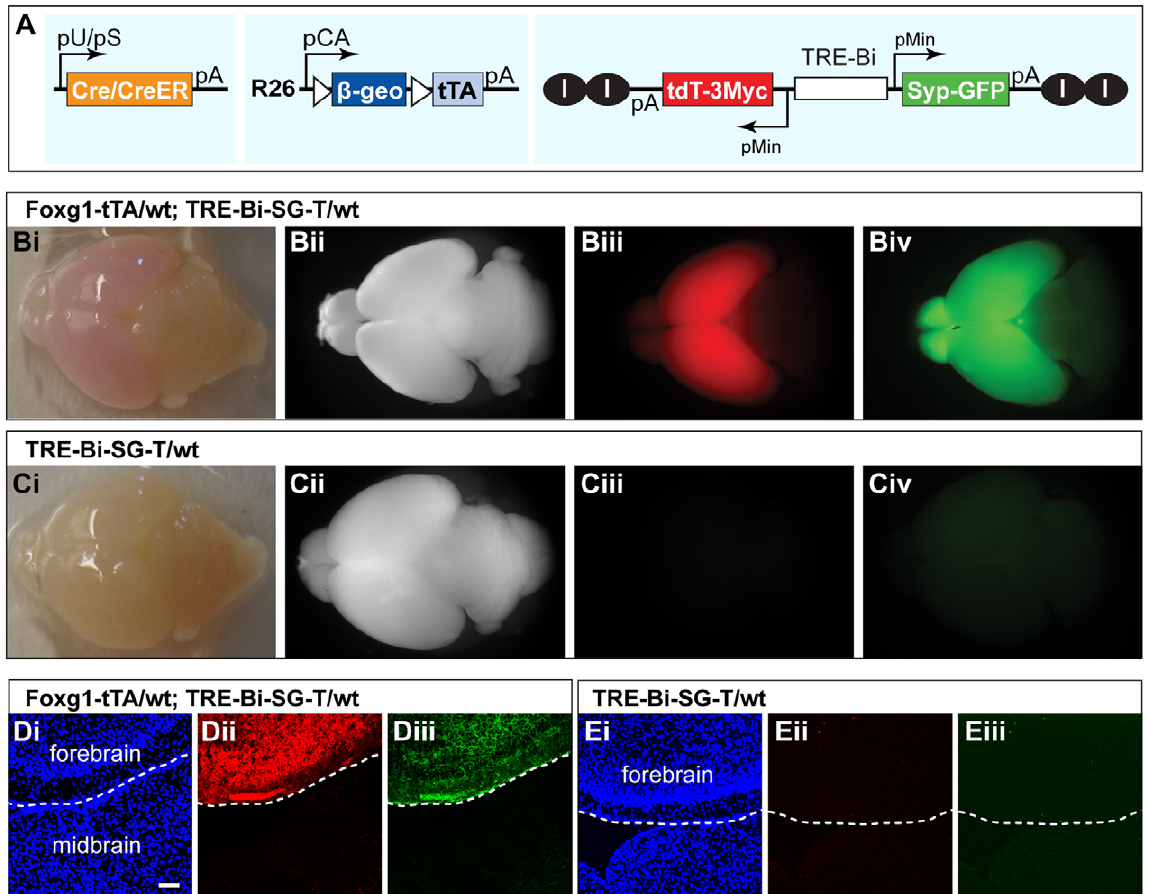
Figure 1. Strategy for creating a transgenic tripartite system for presynaptic labeling invivo . (A) Schematic representation of the three transgenes used for in vivo synaptic labeling: A ubiquitous (pU) or tissue-specific (pS) promoter driven Cre/CreER transgene (left); A Cre/CreER- dependent tTA knock-in (ZtTA) targeted to the ROSA26 locus (middle); A bidirectional TRE (TRE-Bi) transgene driving Synaptophysin-GFP (Syp-GFP) and tdT (TRE-Bi-SG-T) (right). I, chicken b -globin insulators were present in one version of this transgene (iiTRE-Bi-SG-Tii). (B–E) Proof-of-principle experiments showing tTA-dependent expression of Syp-GFP and tdT. (B) Whole-mount brain images of a double transgenic mouse (Foxg1-tTA/wt; TRE-Bi-SG-T/wt). (C) Whole mount brain images of a control mouse (TRE-Bi-SG-T/wt). Bii and Cii, bright field images; Biii and Ciii, tdT expression; Biv and Civ, Syp-GFP expression. (D) Confocal image of a brain section from a P7 double transgenic mouse (Foxg1-tTA/wt; TRE-Bi-SG-T/wt) showing that expression of the TRE-Bi transgene is restricted to forebrain. (E) Confocal image of a brain section from a P7 control mouse (TRE-Bi-SG-T/wt) showing that the TRE-Bi transgene alone is not expressed when a tTA transgene is absent. Di and Ei, DAPI; Dii and Eii, tdT; Diii and Eiii, Syp-GFP. White dashed line demarks the forebrain-hindbrain boundary. Scale bar=50 m